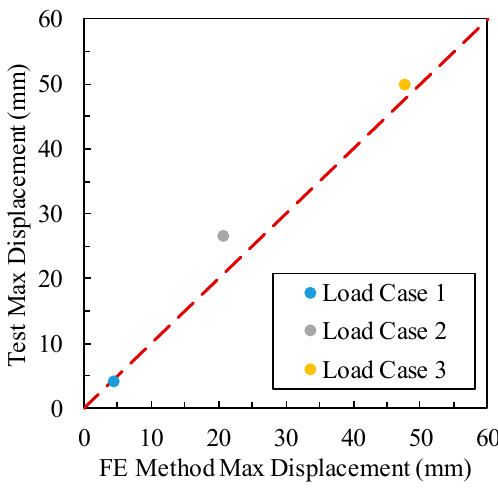
Figure 9. Maximum horizontal displacement in the X-direction: FE method versus test.